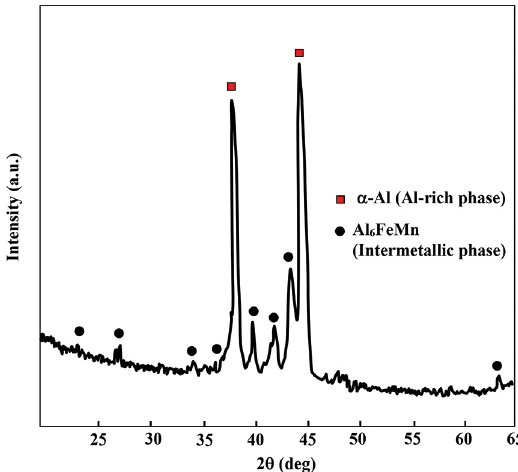
Fig. 5 X-ray diffraction patterns obtained from the Al–1.9Mn–5Fe ternary alloy